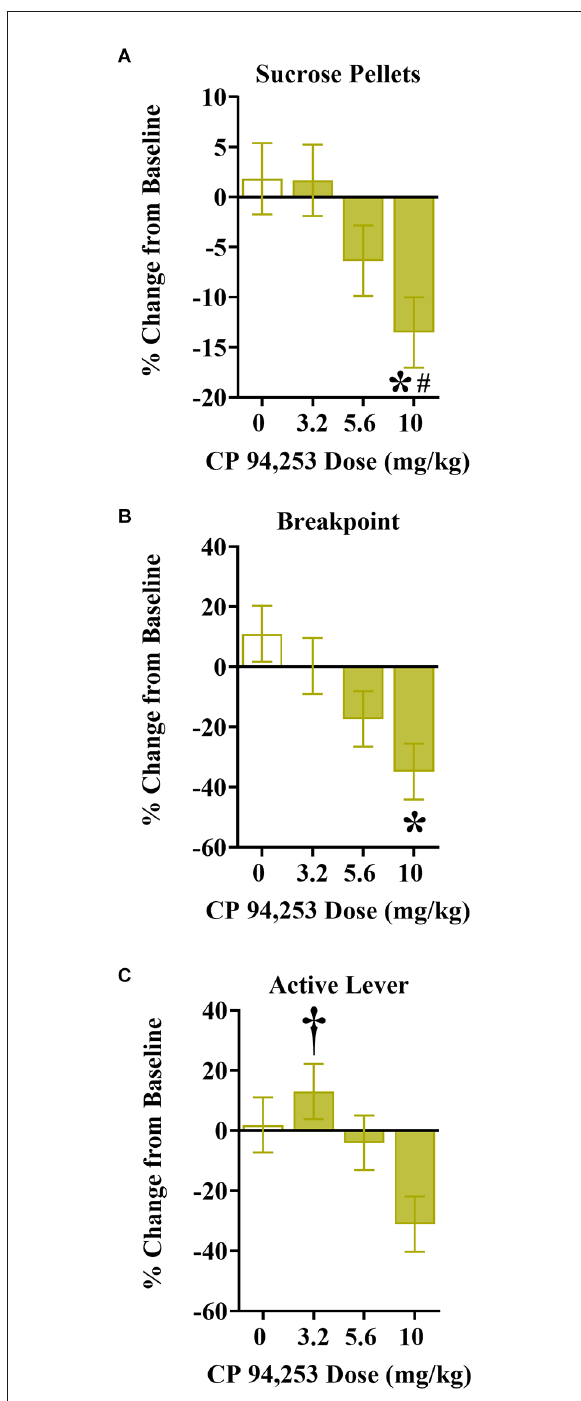
FIGURE6 Effects of CP94253 on mean ± SEM sucrose reinforcers earned (A) , breakpoints (B) , and active lever responses (C) under a PR schedule of reinforcement expressed as a % change from training baseline in male ( n = 8) and female ( n = 15) rats. There were no main effects or interactions with sex, therefore the data are collapsed across sex. *Difference from vehicle, Bonferroni t -tests, p < 0.0167; # difference from 3.2 mg/kg CP94253, Bonferroni t -tests, p < 0.0167; † different from 10 mg/kg CP94253, Bonferroni t -tests, p <